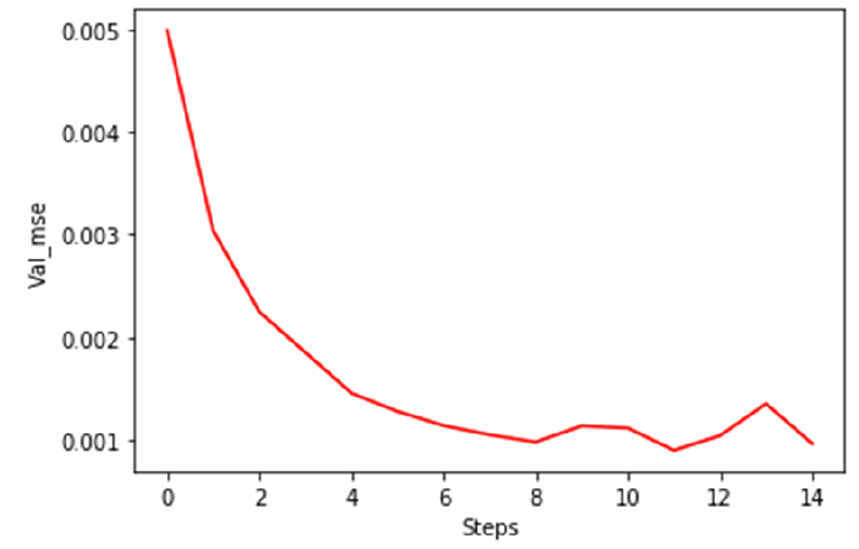
Figure 9. Early stop at Val_mse = 0.001 by monitoring validation MSE. Figure 10. demonstrates the interpolation process of HI with partially labeled data points. Figure 11 shows that a selected model learns from the entire dataset after the interpolation and predicts a similar HI pattern for each turbo